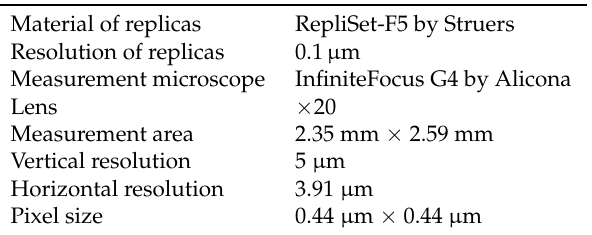
Table 2. Measurement parameters of grinding-wheel AS